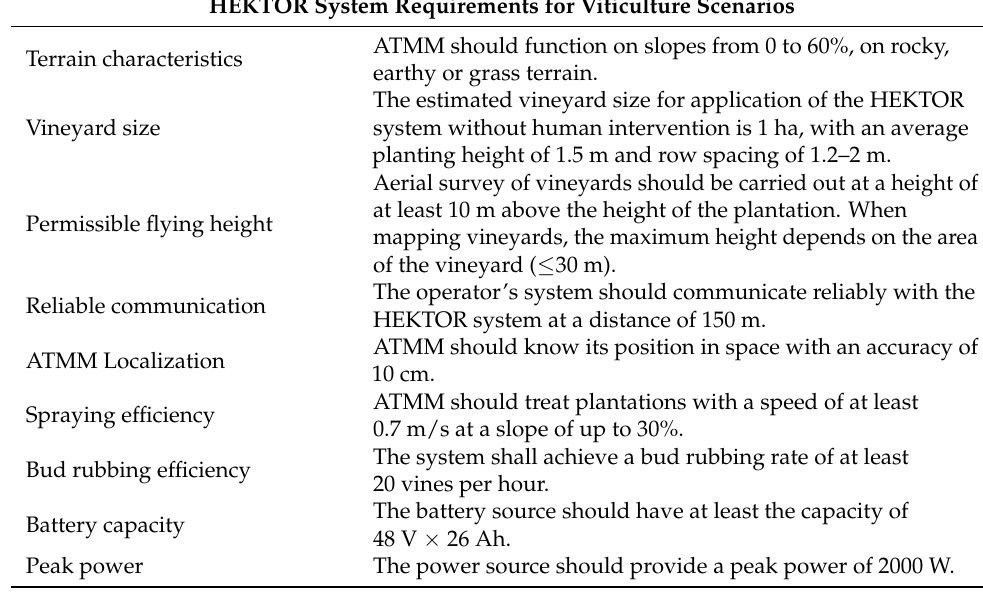
Table 1. The list of selected HEKTOR system